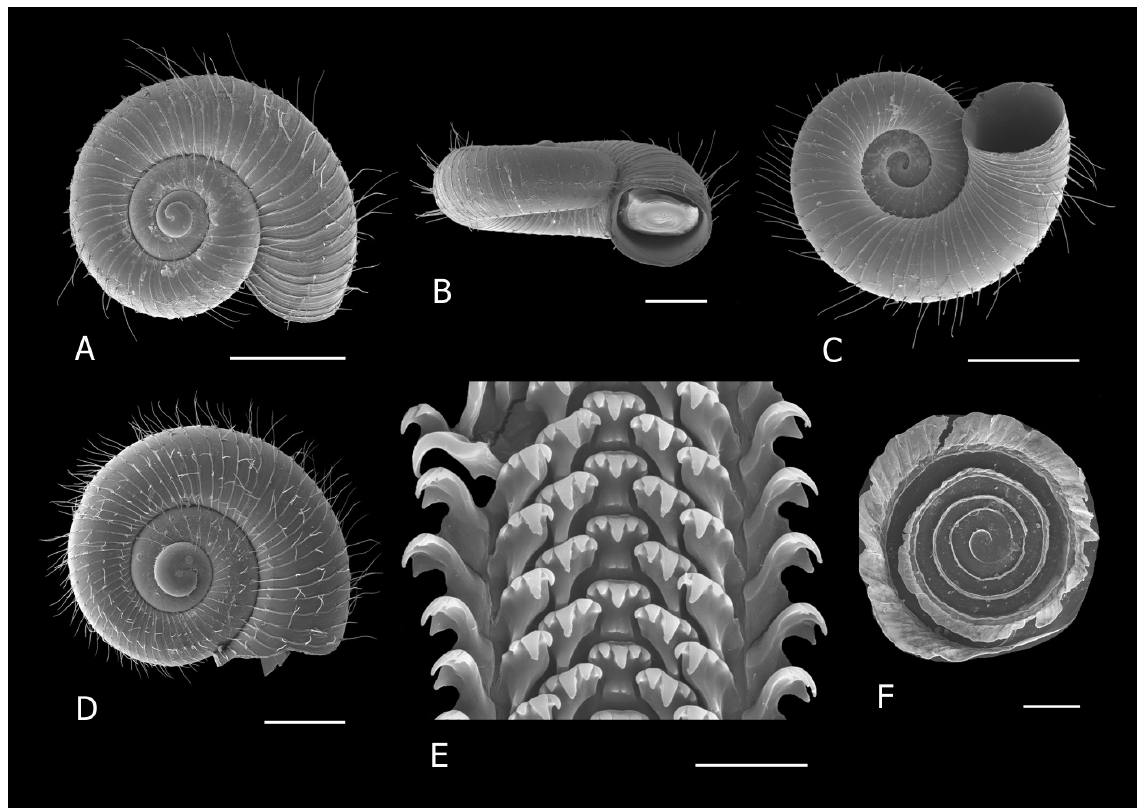
Fig. 32. Afrocyclus bhaca gen. et sp. nov. A . Dorsal view (NMSA V8277). B . Aperture view (NMSA V2075). C . Ventral view (NMSA V2075). D . Juvenile to show detail of axial lamellae of periostracum (ELM D17893). E . Portion of radula (ELM W3856). F . Operculum (NMSA V2075). Scale bars: A, C = 1 mm; B, D = 500 µm; E = 20 µm; F = 200